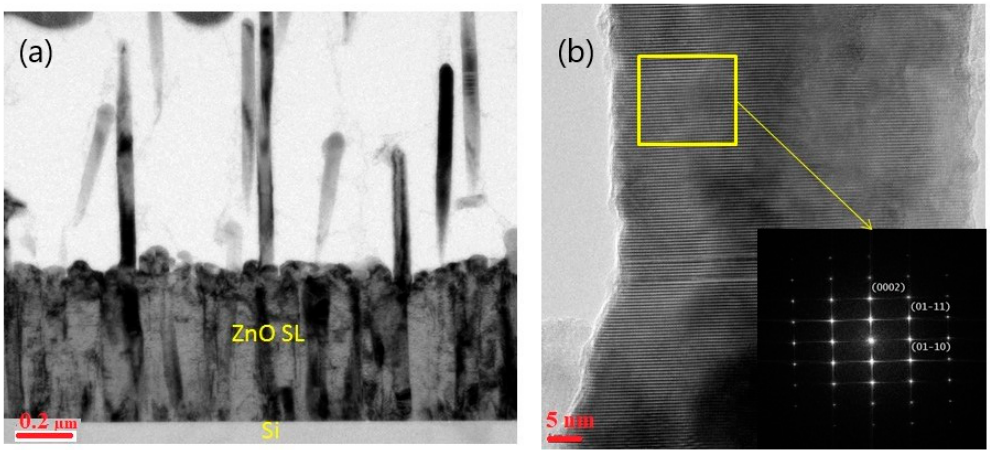
Figure 8. TEM ( a ) & High-Resolution Transmission Electron Microscopy (HRTEM) ( b ) of ZnO NWs grown on Si (100)—ZnO SL at 5